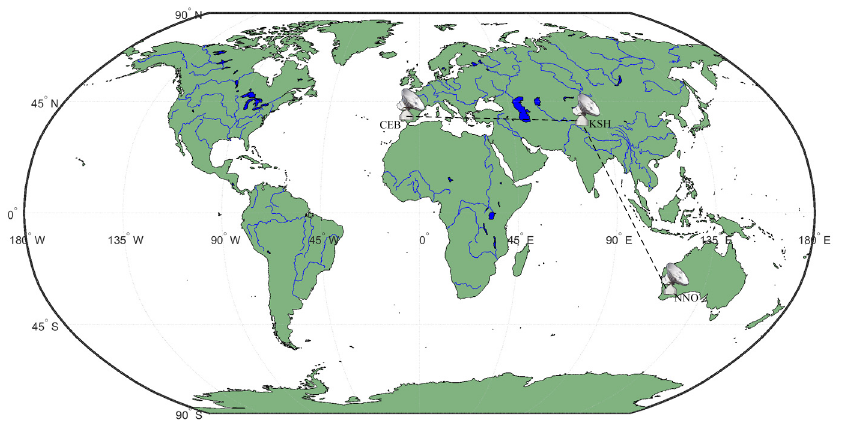
Figure 7. Tracking station distribution and intercontinental baseline: KSH and CEB forming a baseline of about 6400 km, KSH and NNO forming a baseline of about 8000 km, CEB and NNO forming a baseline of about 11,650 km.